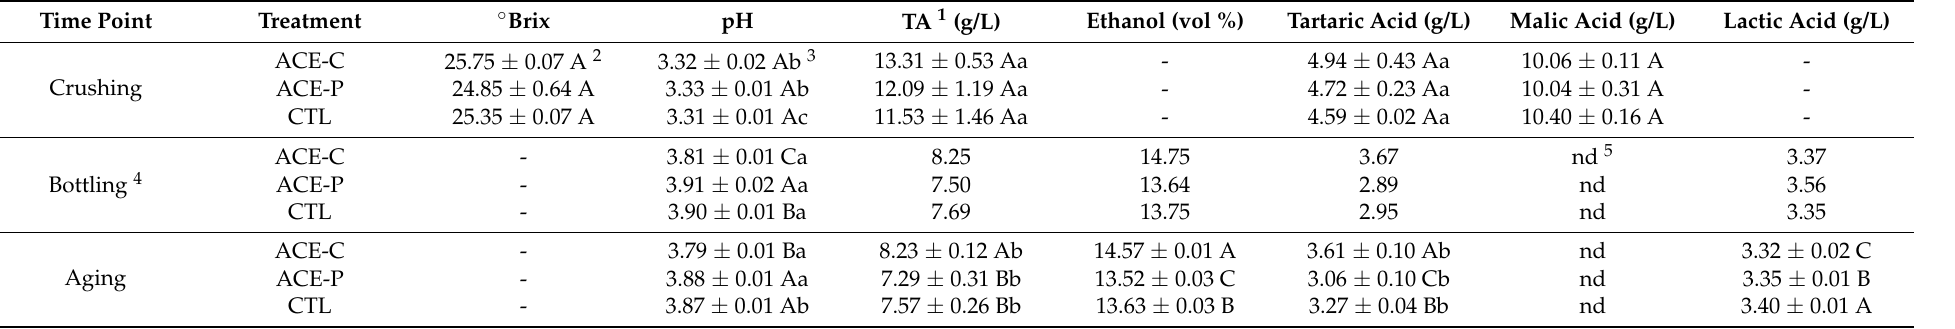
Table 1. Chemical characteristics of the Marquette grape musts and wines at crushing, bottling, and after 5 months aging. Values are mean ± standard deviation ( n =